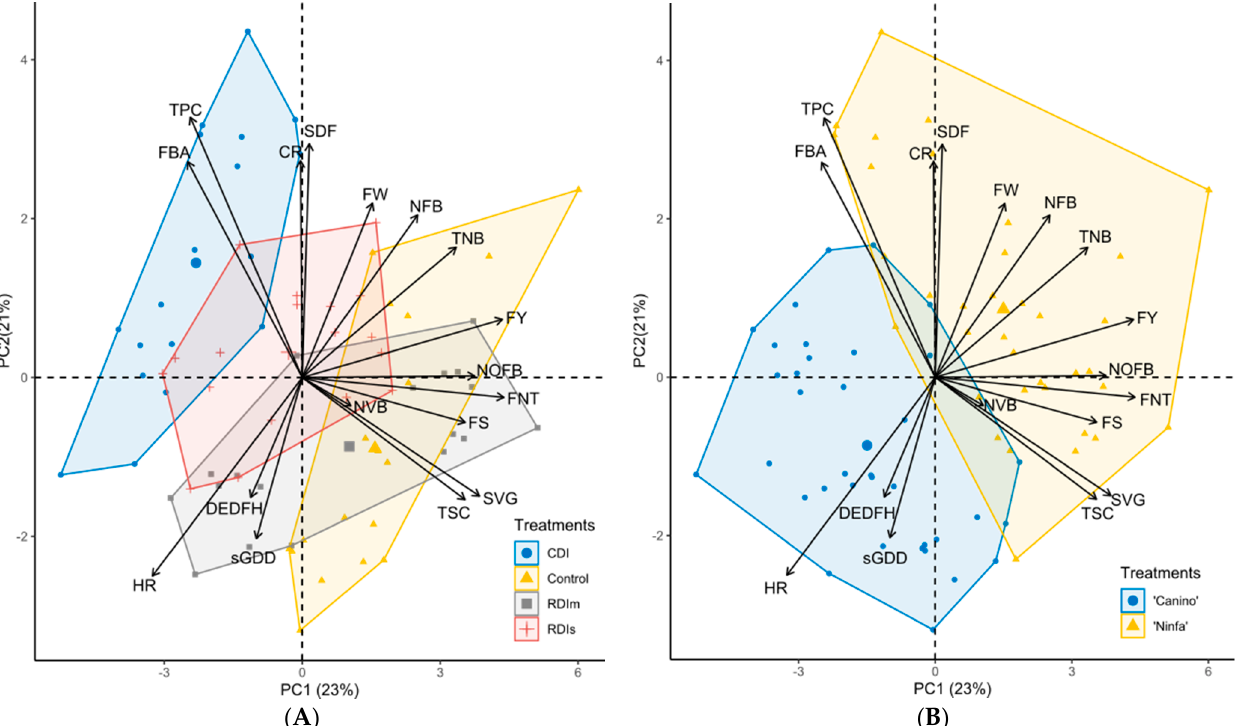
Figure 10. Two biplots of PCA (principal component analyses) conducted separately for the four deficit irrigation treat- ments ( A ) and for the two cultivars ( B ) in a commercial apricot orchard at Wadi El Natrun, Northern Egypt over 2016–2018.